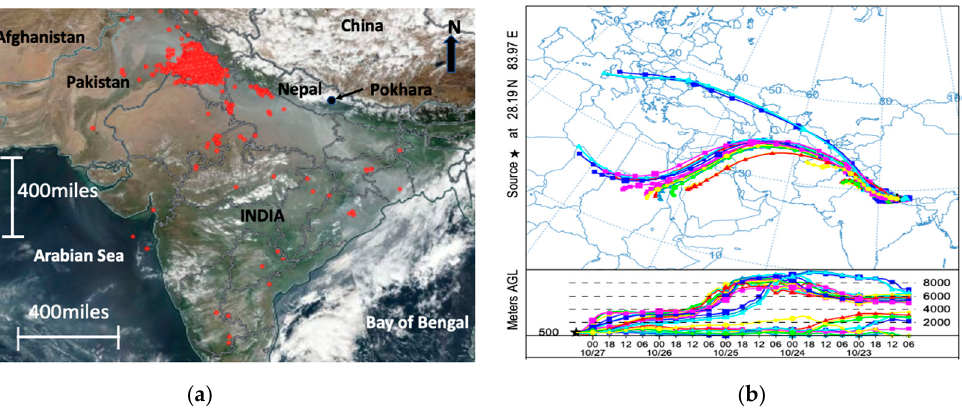
Figure 9. ( a ) The corrected reflectance true-color MODIS satellite image of the day 27 October 2017, shows intensive air pollution plumes over the IGP. ( b ) NOAA HYSPLIT MODEL Back Trajectories ending at 0600UTC on 27 October 2017. Horizontal and vertical scales of 400 miles on the left figure are